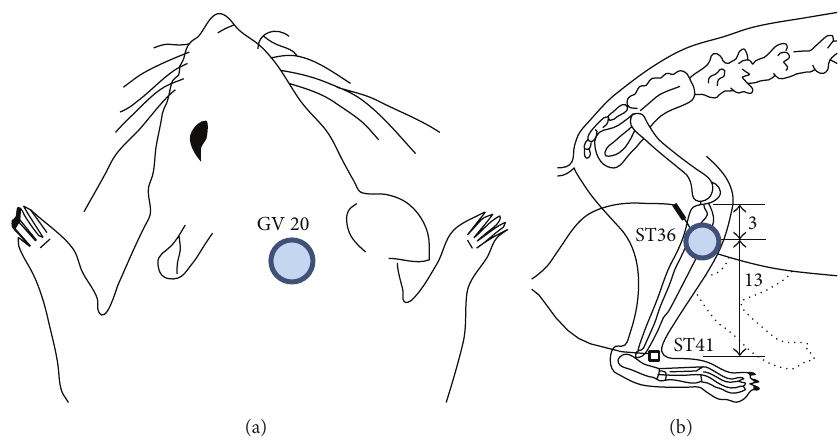
Figure 2: Schematic diagram of the stimulated